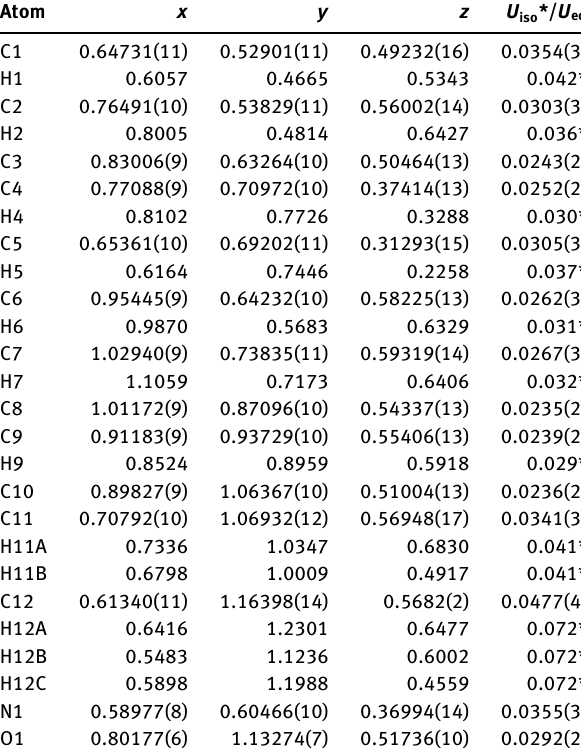
Table 2: Fractional atomic coordinates and isotropic or equivalent isotropic displacement parameters (Å 2